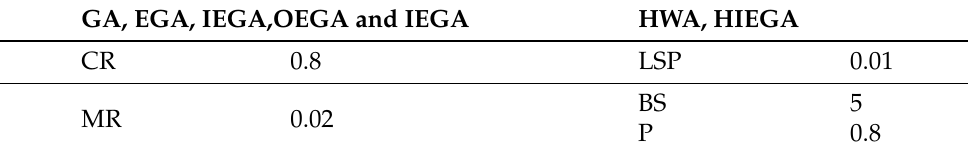
Table 2. The parameters of the